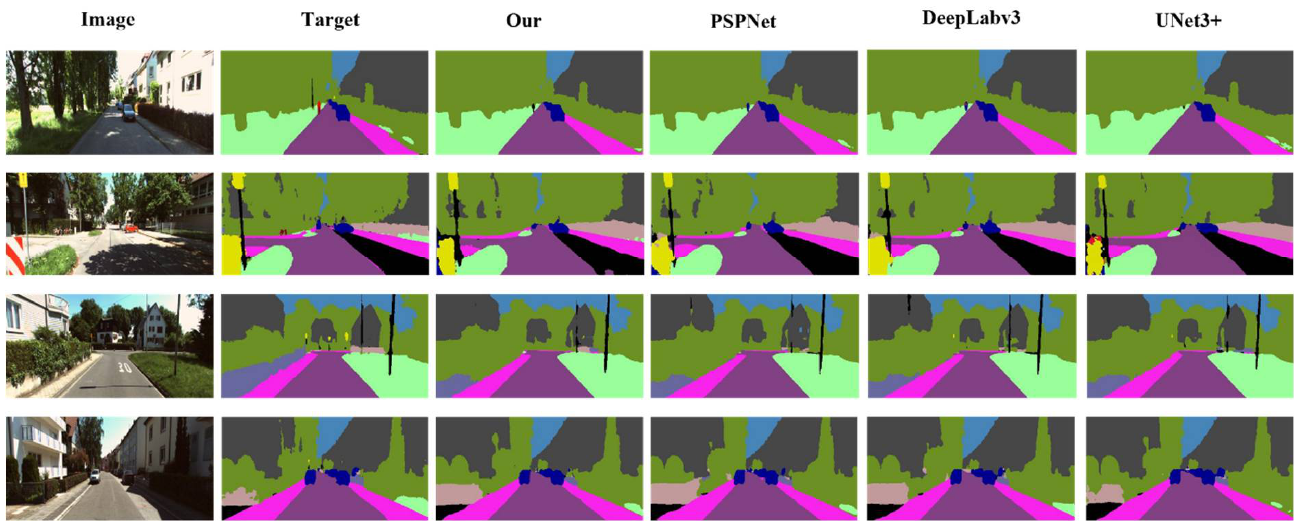
Figure 17. Visualization results on KITT-360 (including simple class).